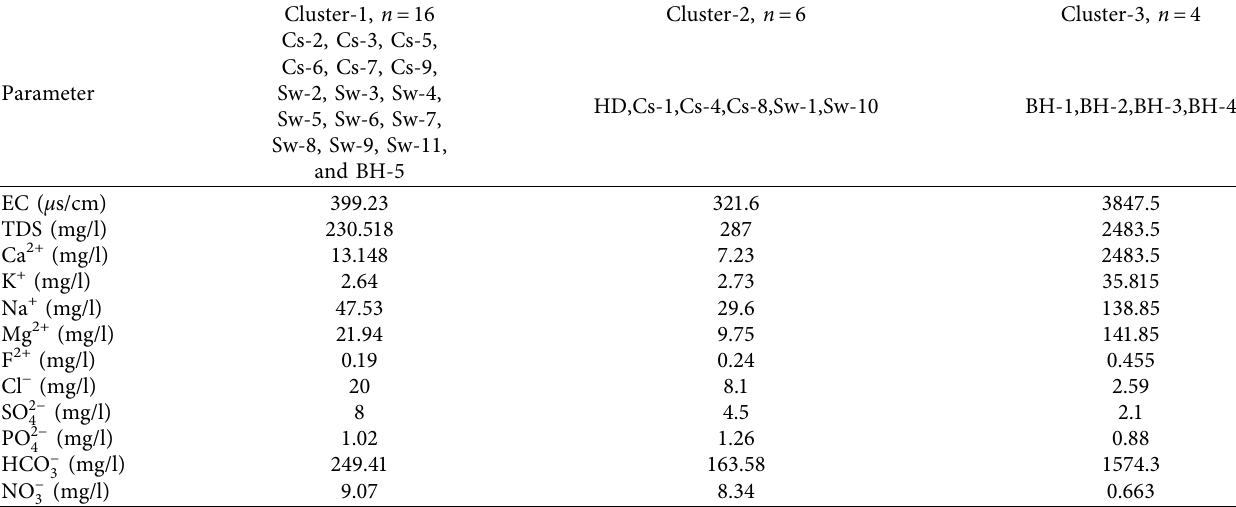
Table 3: Mean concentrations of clustered parameters.